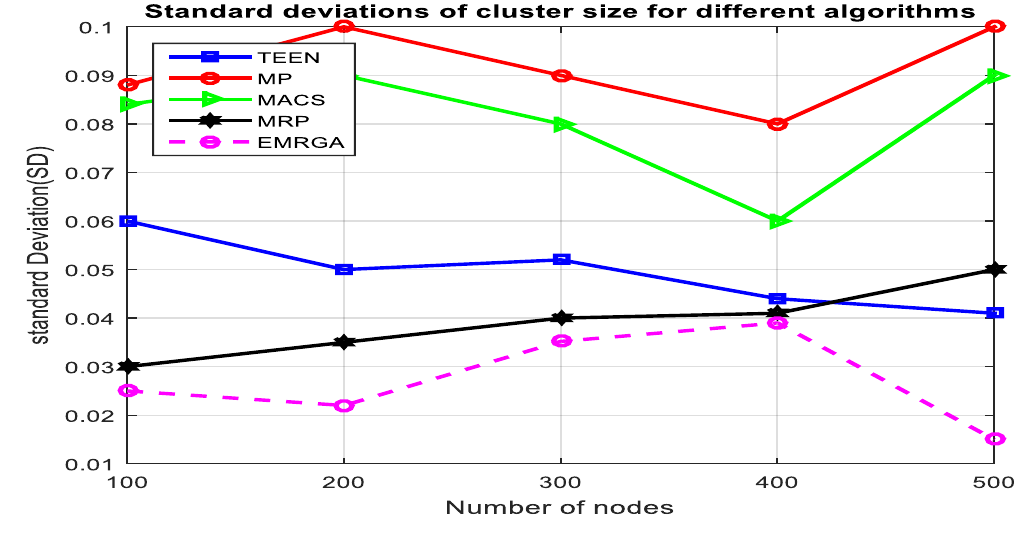
Figure 7. Standard deviations.